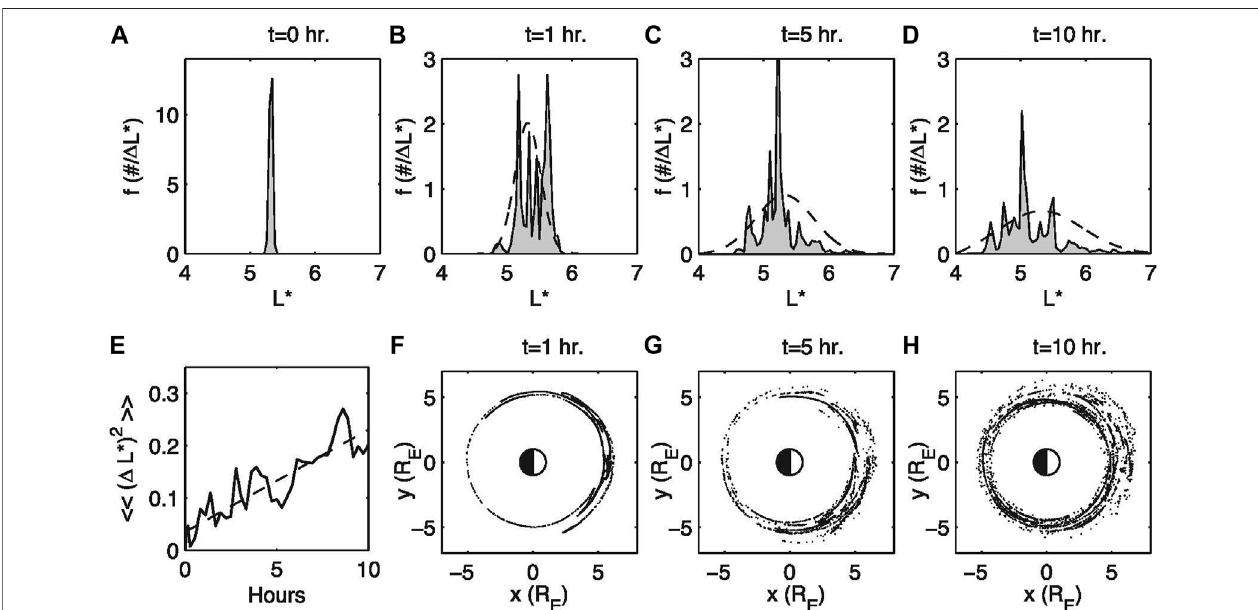
FIGURE 7 | Time evolution of a normalized distribution function, f , during a test particle simulation including 10,000 equatorial guiding centers injected in electric and magnetic fi elds provided by the Lyon-Fedder-Mobarry (LFM) global MHD simulation code (Lyon et al., 2004) during a 10 h time interval (3 January 2003) with “ nothing unusual ” (solar wind speed ~550 km / s , density ~10 cm − 3 and IMF B fl uctuating between ± 10 nT). The distribution is (A) initially radially localized at L p (cid:1) 5 . 3, z and it spreads over time in L* (B – D) , to encapsulate the time evolution of the locations of the tracked test particles (F – H) . The time evolution of the distribution function representing the test particles is compared to the time evolution of the solution of the diffusion equation [dash lines in panels (B – D) ], highlighting signi fi cant discrepancies, even after many drift periods (from Kress et al., 2012).